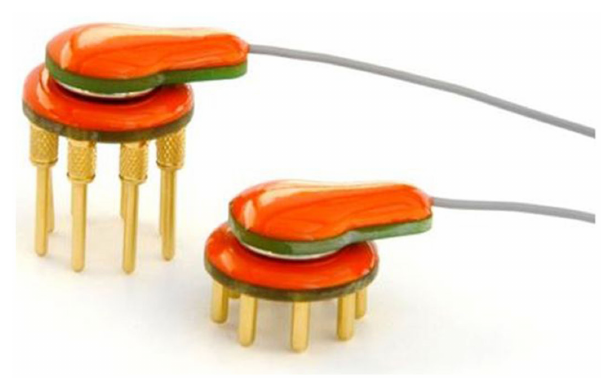
FIGURE 2 |A photograph of the Sahara dry electrodes used in this study. The left electrode is designed for people with longer hair, and the right electrode is designed for people with less or no hair. In this study, the experimenter selected the electrode that was best for each subject. Other testing (not reported here) showed that these two electrodes produced equivalent signals.